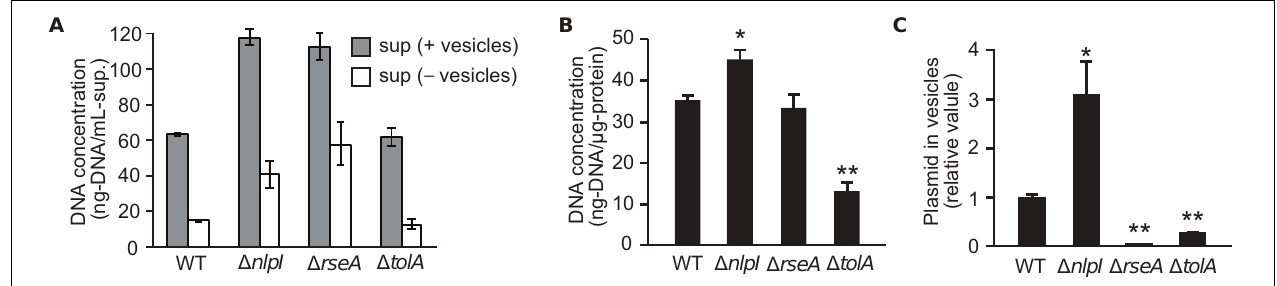
FIGURE 2 | DNA associated with vesicles. E. coli BW25113 WT, (cid:49) nlpI , (cid:49) rseA , and (cid:49) tolA , all harboring pUC19, were grown overnight in LB medium containing ampicillin. (A) The extracellular DNA (eDNA) concentration of the supernatant (sup.) with and without vesicles was measured by PicoGreen. (B) DNA associated with vesicles derived from E. coli . Vesicles were lysed with guanidium thiocyanide prior to labeling. DNA concentrations were measured by PicoGreen, and the values were normalized to the vesicle protein concentration. (C) The ratio of plasmid to DNase I-treated vesicles. The amount of plasmid and vesicles were measured by real-time PCR and nano-tracking analysis, respectively, and the values (plasmid/vesicle) relative to control (WT/pUC19) are provided. In all figures, the data are presented as the mean ± standard deviation from three replicates. *P < 0.05; * *P < 0.005 compared to WT.